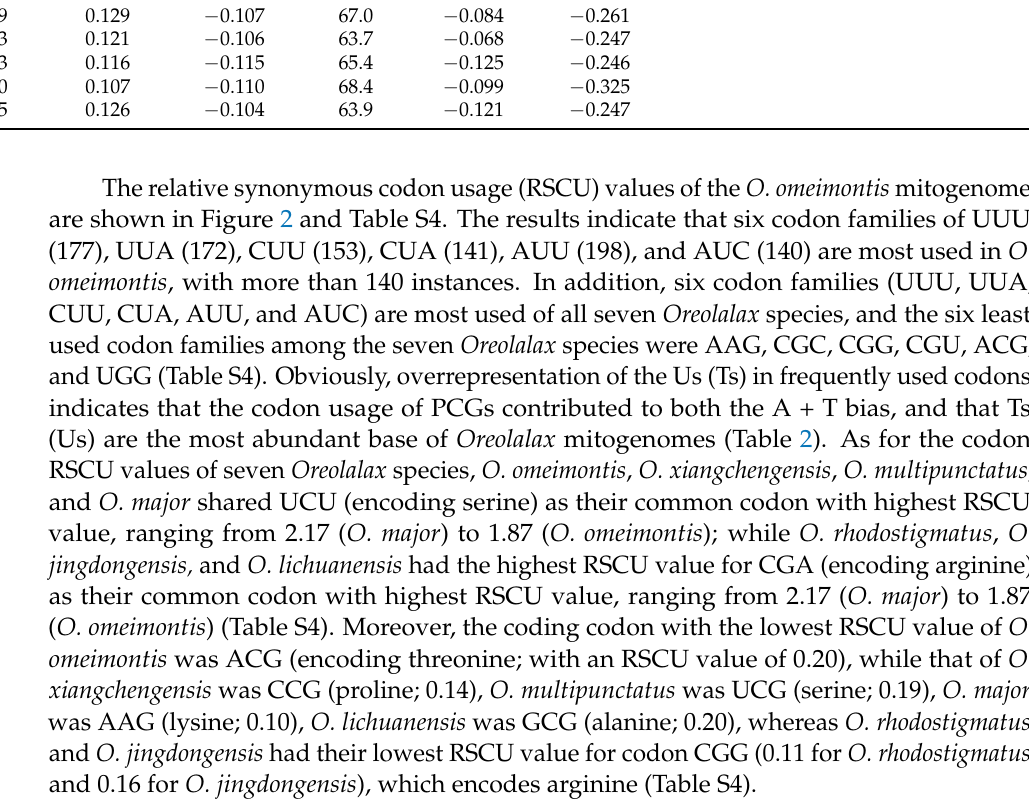
Table 2. Base composition and skewness of the seven Oreolalax species.